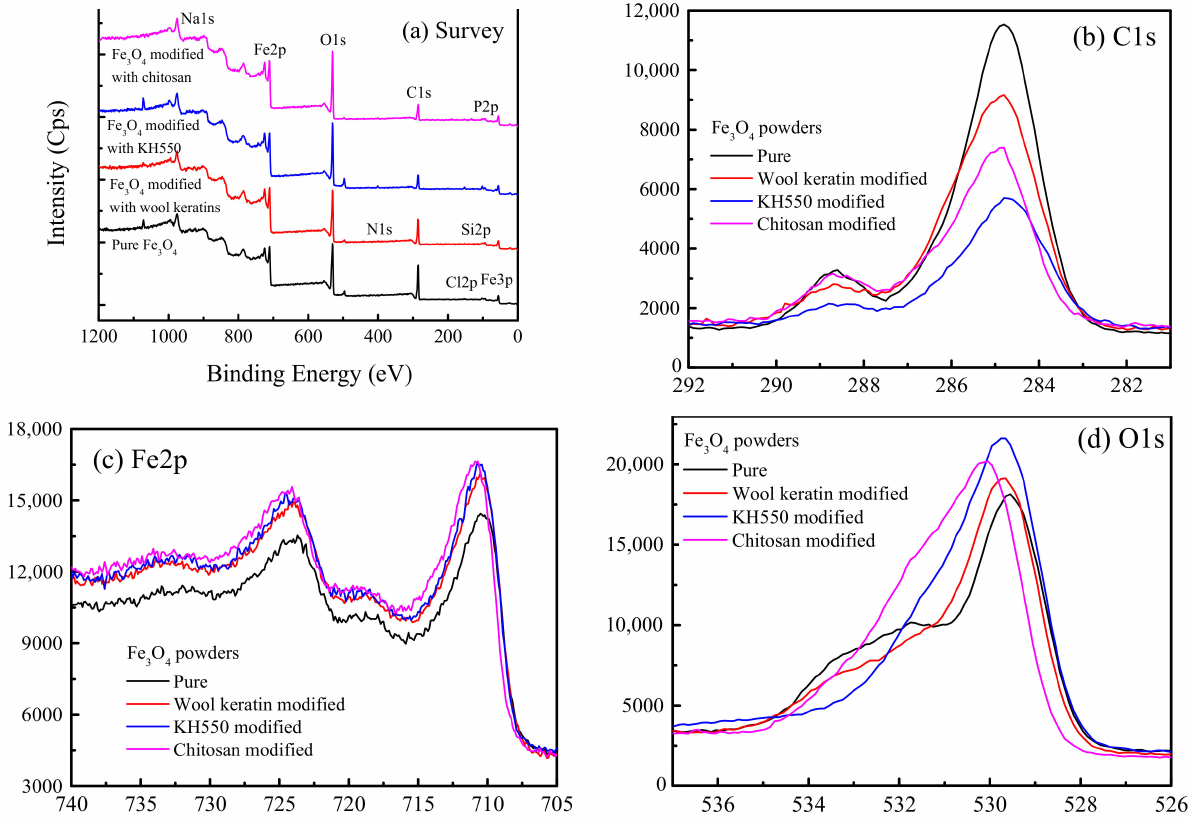
Figure 4. The X-ray photoelectron spectroscopy (XPS) spectra of the pure, wool keratin modified, KH550 modified, and chitosan modified Fe 3 O 4 powders: ( a ) Survey, ( b ) C1s, ( c ) Fe2p, and ( d )